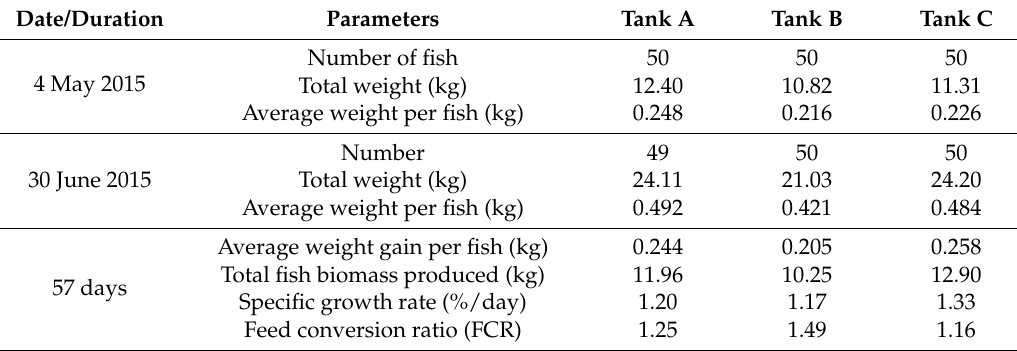
Table 2. Tilapia growth in three identical aquaponic systems, and calculation of feed conversion ratio (kg feed /kg fish biomass ).